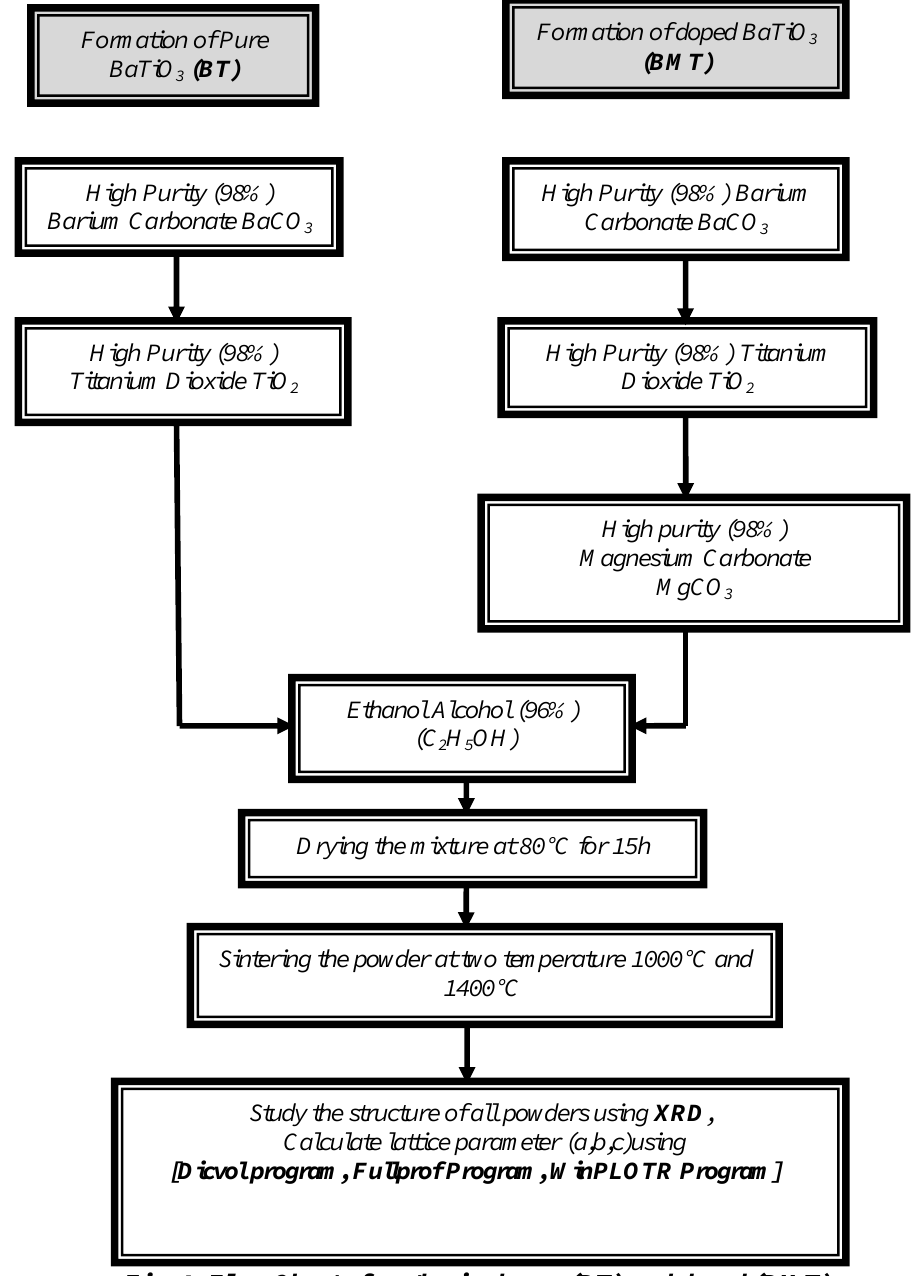
Fig. 4: Flow Chart of synthesized pure (BT) and doped